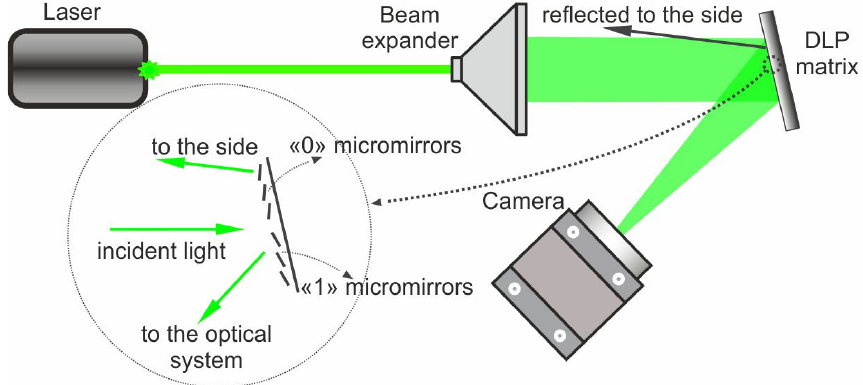
Figure 6. Experimental apparatus. The dashed circle illustrates the principle of DLP matrix operation.